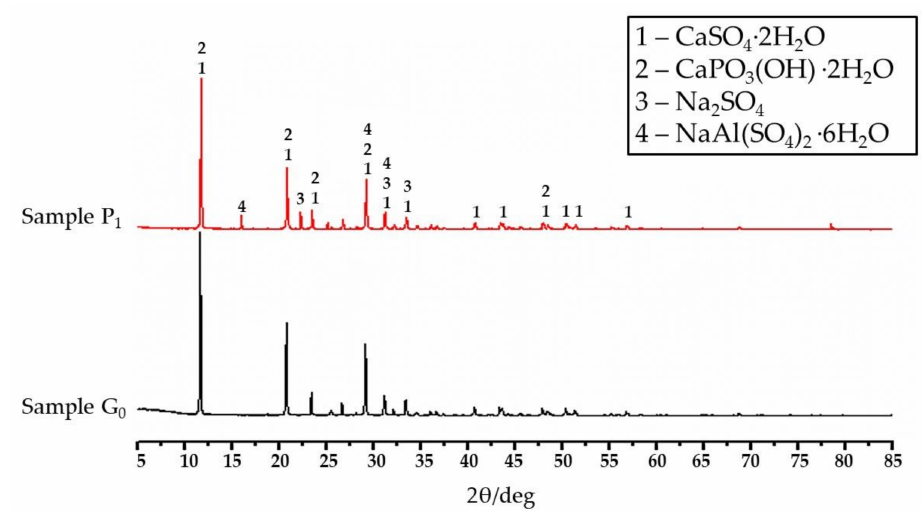
Figure 5. XRD diffraction image of phosphogypsum.